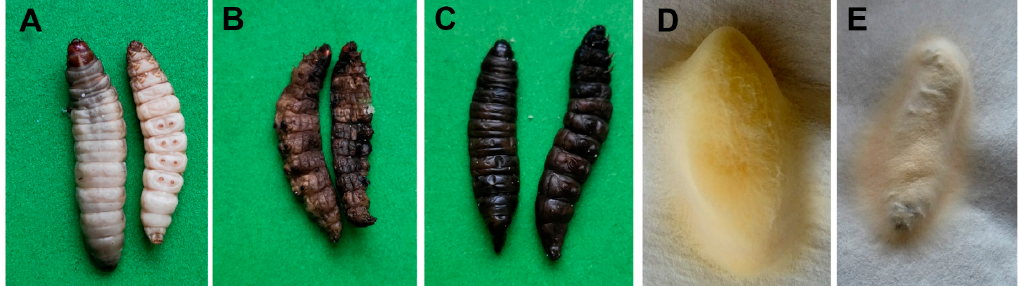
Figure 2. Phenotypes of larvae that died after injection with C. militaris conidia. ( A )—mummification, ( B )—defective mummies, ( C )—bacterial decomposition, ( D )—conidiation at 15 °C, ( E )—conidiation at 25 °C.